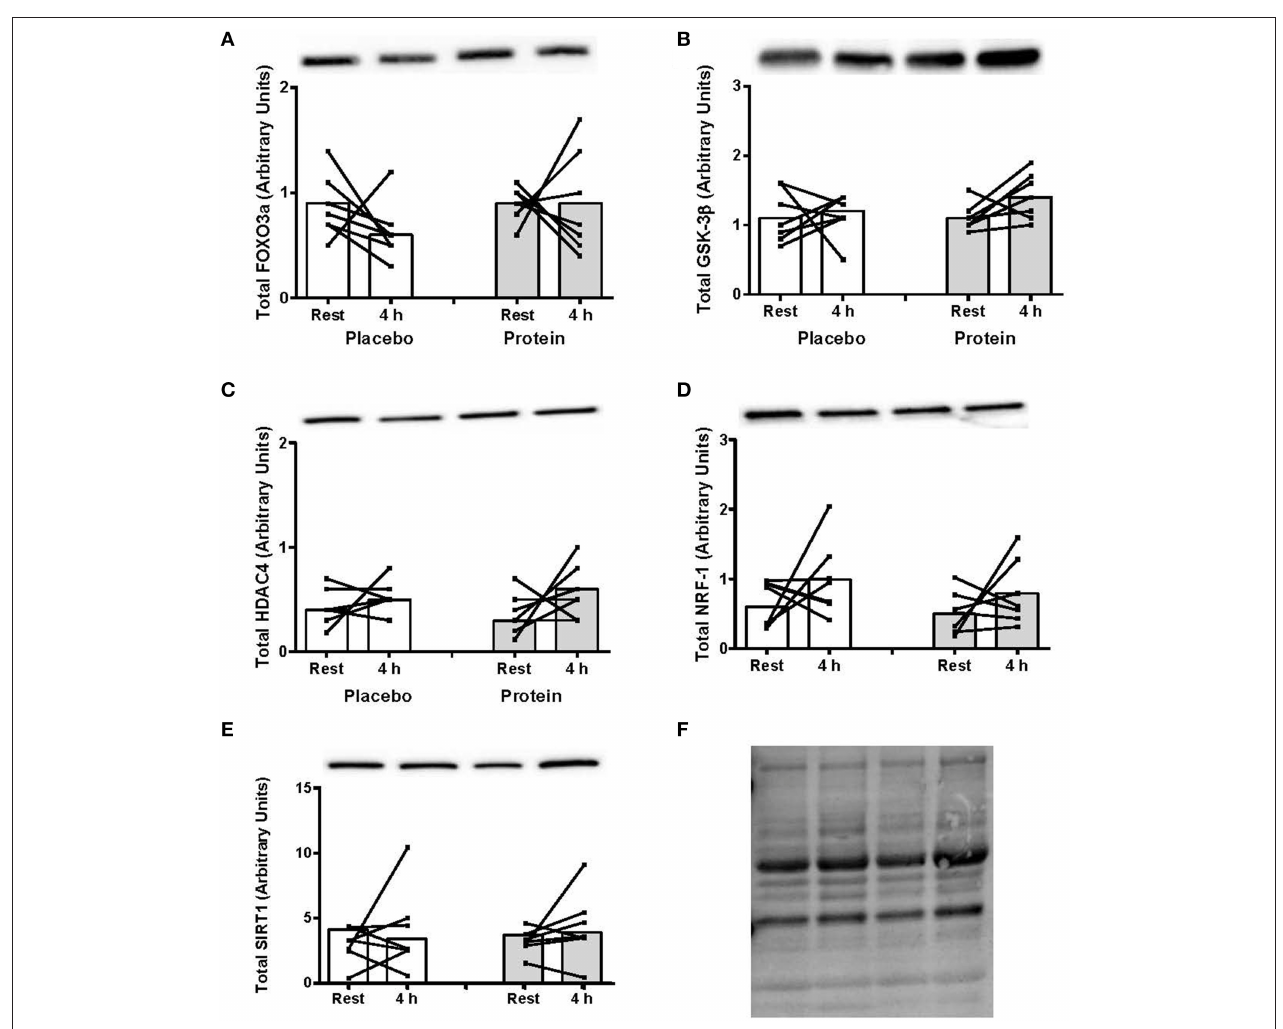
FIGURE 3 | (A) Foxo3a, (B) GSK-3 β , (C) HDAC4, (D) NRF-1, and (E) SIRT1 total protein content at rest and at 4h post-exercise recovery following a concurrent exercise session of resistance (8 sets of 5 leg extension at 80% 1-RM) and endurance (30min cycling at 70% VO 2peak ) exercise and ingestion of either 500-mL PLA or PRO beverage immediately after exercise. Values are arbitrary units expressed relative to RNU48 and presented as individual data with group mean ( n = 7 ). (F) Stain-free image of total protein